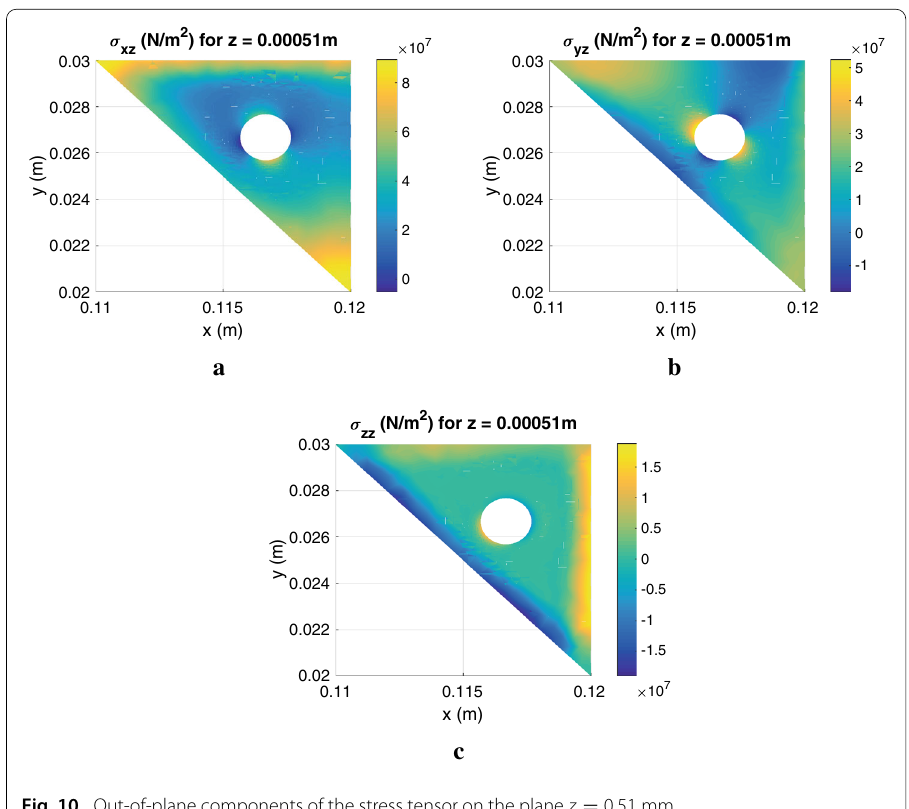
Fig. 10 Out-of-plane components of the stress tensor on the plane z = 0 . 51 mm